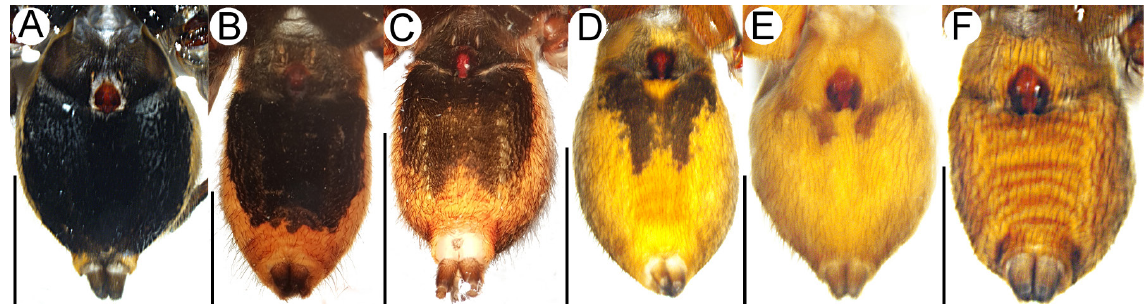
Fig. 15. Lycosa piochardi Simon, 1876, ♀♀, common ventral abdominal coloration morphs. A . Black patch reaches posterior tip (HUJ INV-AR20735). B . Black patch does not reach posterior tip (HUJ INV- AR20626). C . Black patch with shallow notch (HUJ INV-AR20763). D . Black patch with deep notch (HUJ INV-AR20913). E . Black patch divided (HUJ INV-AR20671). F . No black patch (HUJ INV- AR20803). Scale bars = 10 mm. Photos by I. Armiach